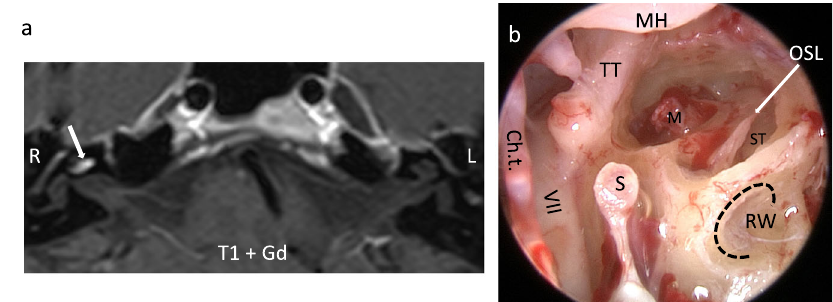
Fig. 1 Intracochlear tumor and situs after subtotal cochlear removal. a Axial MRI (T1-w with Gd- enhancement) showing an intracochlear schwannoma ( → ) in the right cochlea. Although being a very rare disease, we can gain interesting insights into inner ear (patho)physiology from its diagnostics and treatment. MRI: Dr. Georg Eisele, Radiologisches Zentrum, Wangen, Germany (with permission). b Intraoperative endoscopic view after tumor resection through subtotal cochleoectomy and before cochlear implantation and defect reconstruction. During surgery, the bony arch (dashed line) of the round window is preserved for securing the electrode 14 . The Ductus reuniens courses along that bony arch of the round window and in the depth of the hook region connects the cochlear duct with the saccule in the vestibule (Fig. 2), 33 . Ch. t. chorda tympani, Gd Gadolinium, L left, M modiolus (2nd cochlear turn), MH malleus handle, OSL osseus spiral lamina, R right, RW round window, S stapes, ST scala tympani (basal cochlear turn), TT tensor tympani muscle,